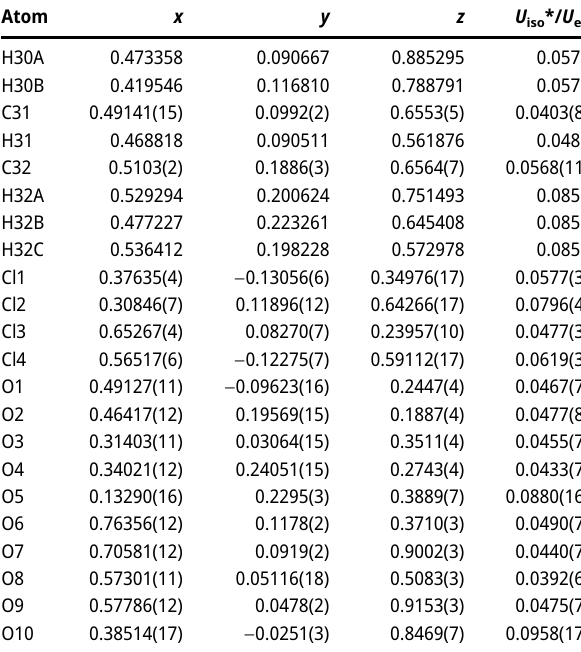
X-ray single crystal di ff raction. It is a key chemical interme-